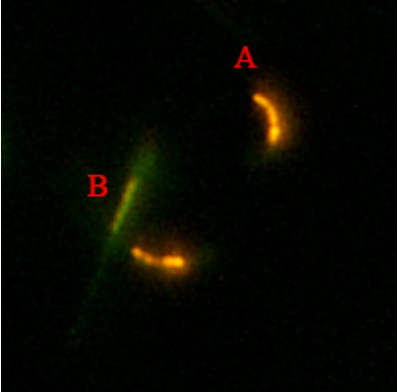
Figure 3. Assessment of sperm mitochondria membrane potential using JC-1. Sperm with red fluo- rescence ( A ) considered as with a high mitochondrial membrane potential; those with green fluo- rescence ( B ) considered as with low mitochondrial membrane potential (×200 Magnification).